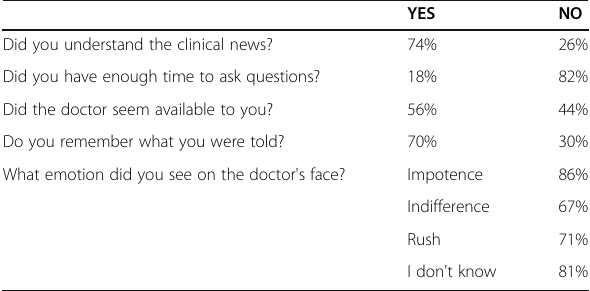
Table 1 (abstract A166). Rehabilitator-doctor